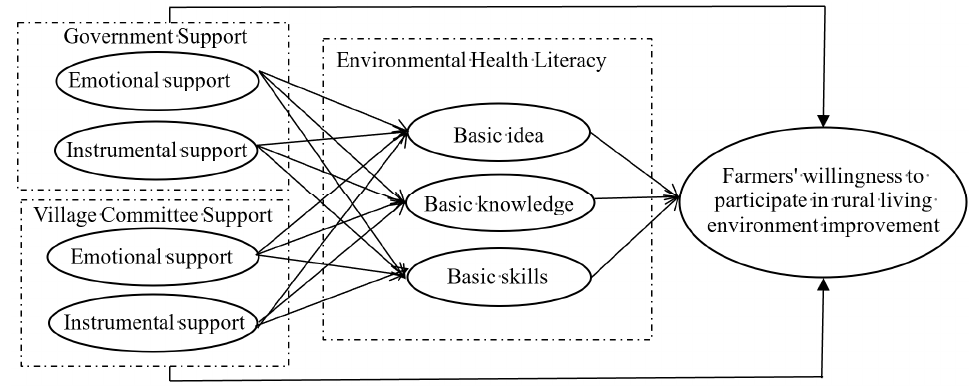
Figure 1. Conceptual